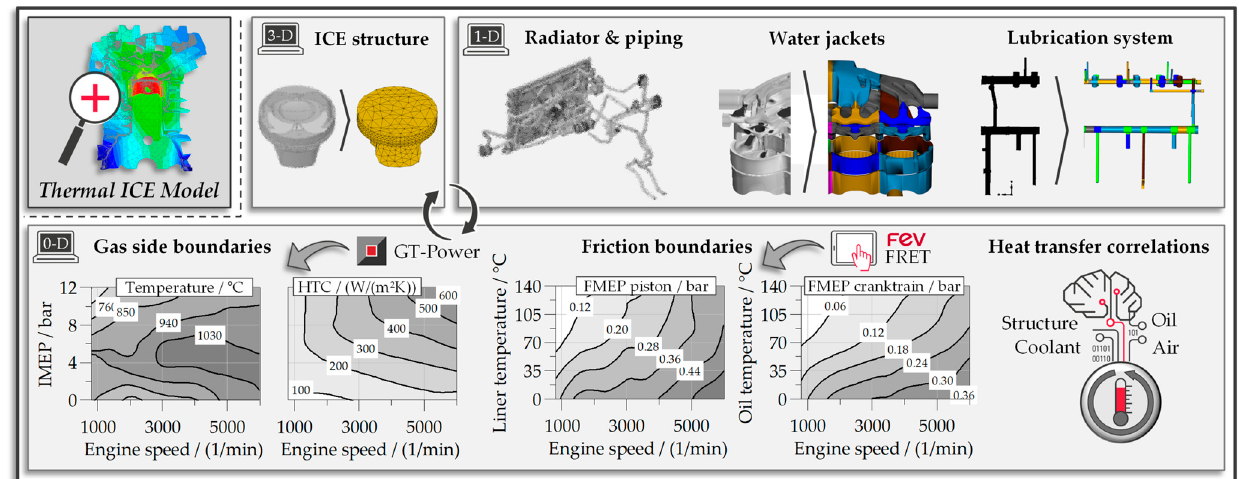
Figure 5. Advanced thermal management simulation model for an internal combustion